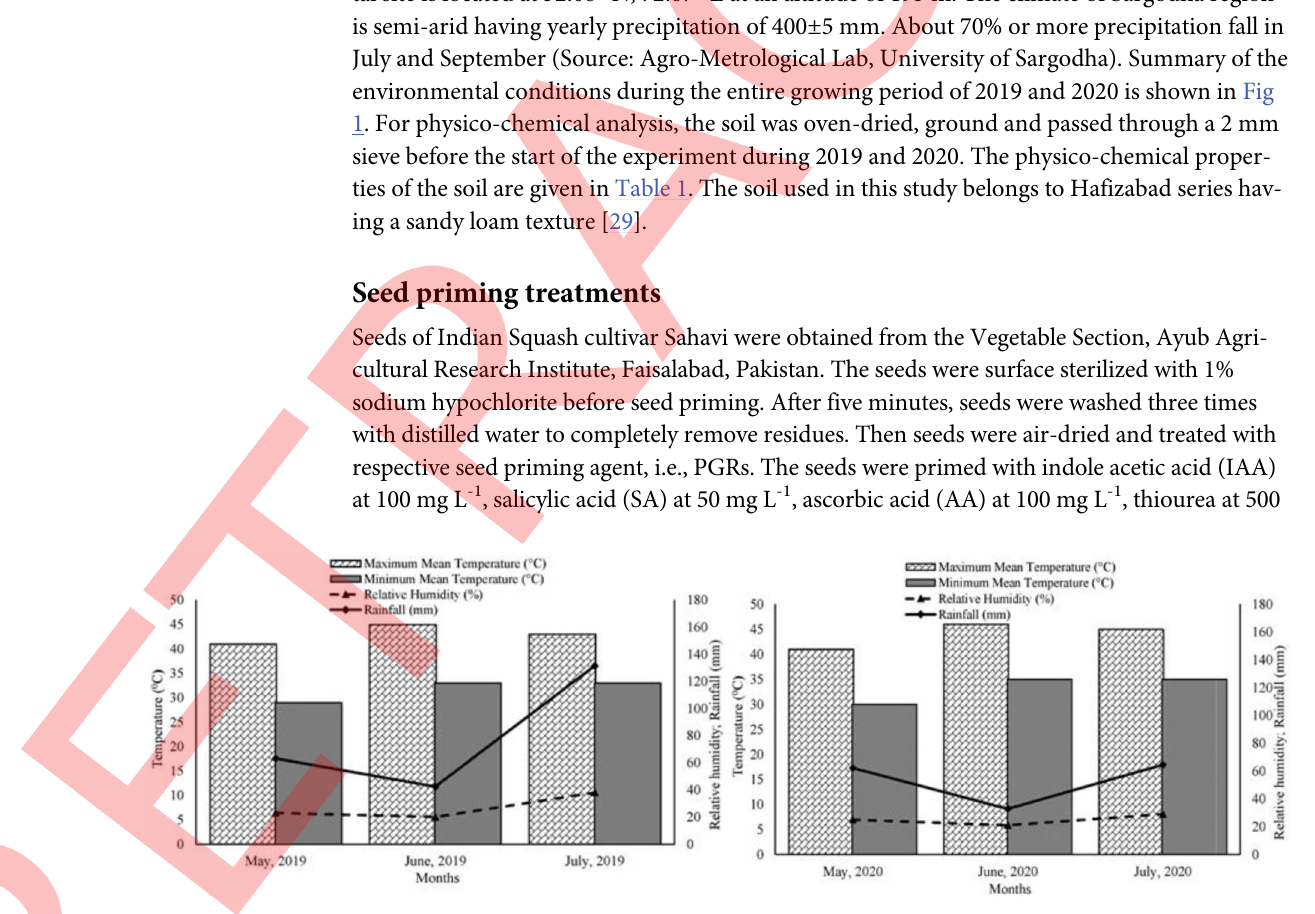
Fig 1. Meteorological data recorded at College of Agriculture, University of Sargodha, Sargodha, Punjab, Pakistan during 2019 and 2020.